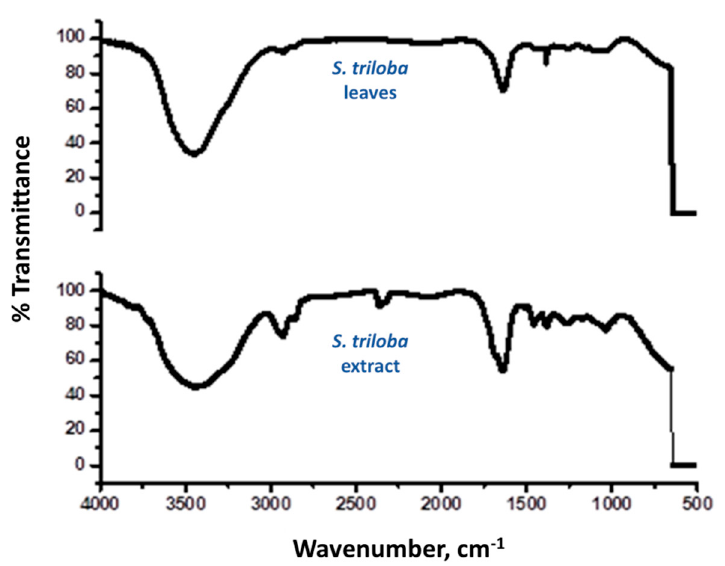
Figure 11. FTIR spectra of S. triloba leaves ( Top panel ) and its crude acetone extract ( Bottom panel ).